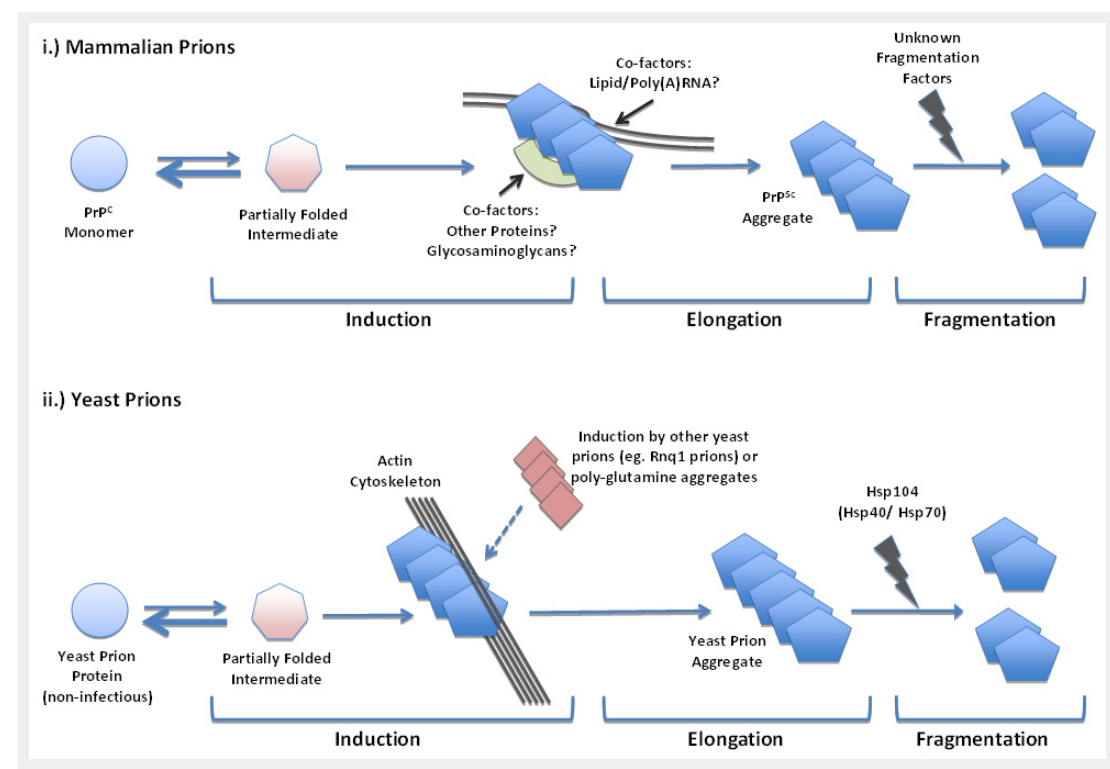
The induction, propagation and fragmentation of mammalian and yeast prions are compared. Partial unfolding of proteins with prion domains and/or the presence of other cellular factors may influence susceptibility to misfolding. (i) In the presence of a prion seed, PrP C is converted to PrP Sc thereby elongating the PrP Sc fibril. Conversion is likely to be aided by the presence of molecules such as poly(A)RNA, lipid and/or other co-factors and aggregates are fragmented by an as yet unidentified fragmentation process. (ii) Induction of yeast prions depends on interaction with actin cytoskeleton and/or cross-seeding by other yeast prions or yeast proteins with Gln/Asn-rich domains. Propagation and fragmentation of yeast prion aggregates is performed by the yeast protein chaperones Hsp104 and Hsp70/